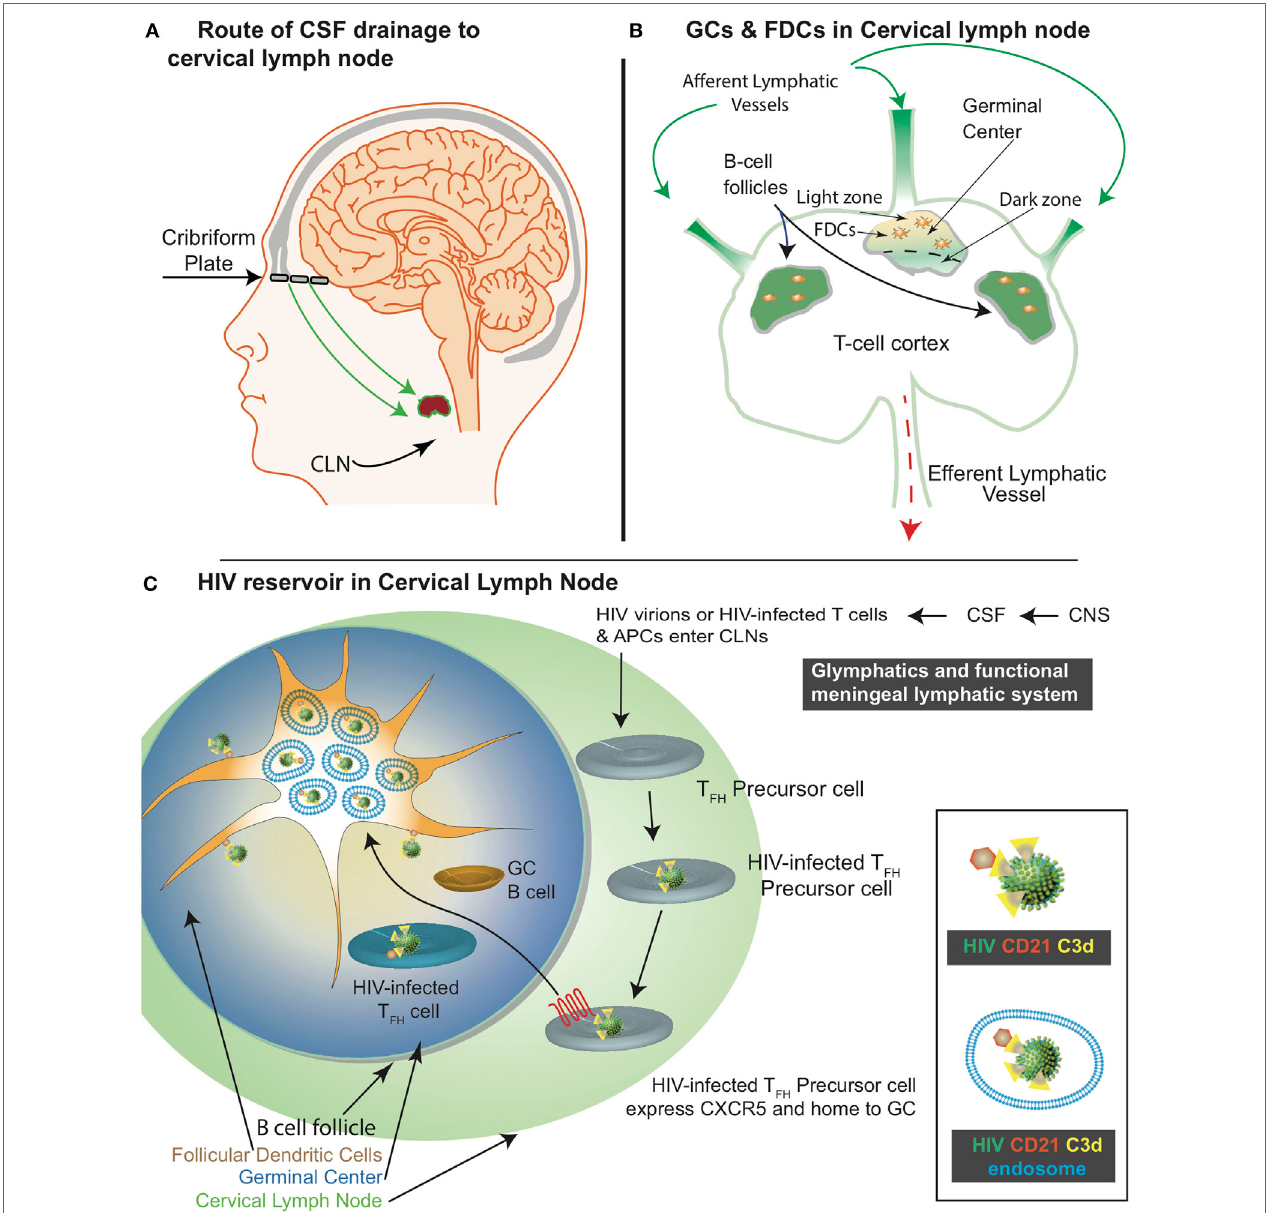
FigURe 1 | Schematic representation of the central nervous system (CNS)-associated meningeal lymphatic system and the human immunodeficiency virus (HIV) reservoir in the cervical lymph nodes (CLNs). (A) The functional meningeal lymphatic vessels drain cerebrospinal fluid (CSF). T cells and antigen-presenting cells migrate with the CSF along the nasal lymphatic pathways through the cribriform plate to access the CLNs. (B) CSF enters the CLN via the afferent lymphatic vessel and exits through the efferent lymphatic vessels. Germinal center (GC) is located within the B-cell follicle. The follicular dendritic cells (FDCs) are located within the light zone of the GC. (C) Within the CLNs, HIV infects T follicular helper precursor cells, which subsequently express CXCR5 and migrate to the light zone. As depicted in the inset, CD21 interacts with C3d on HIV surface. This interaction results in HIV acquisition by the FDCs. Majority of the FDC associated HIV cycles through the endosomal